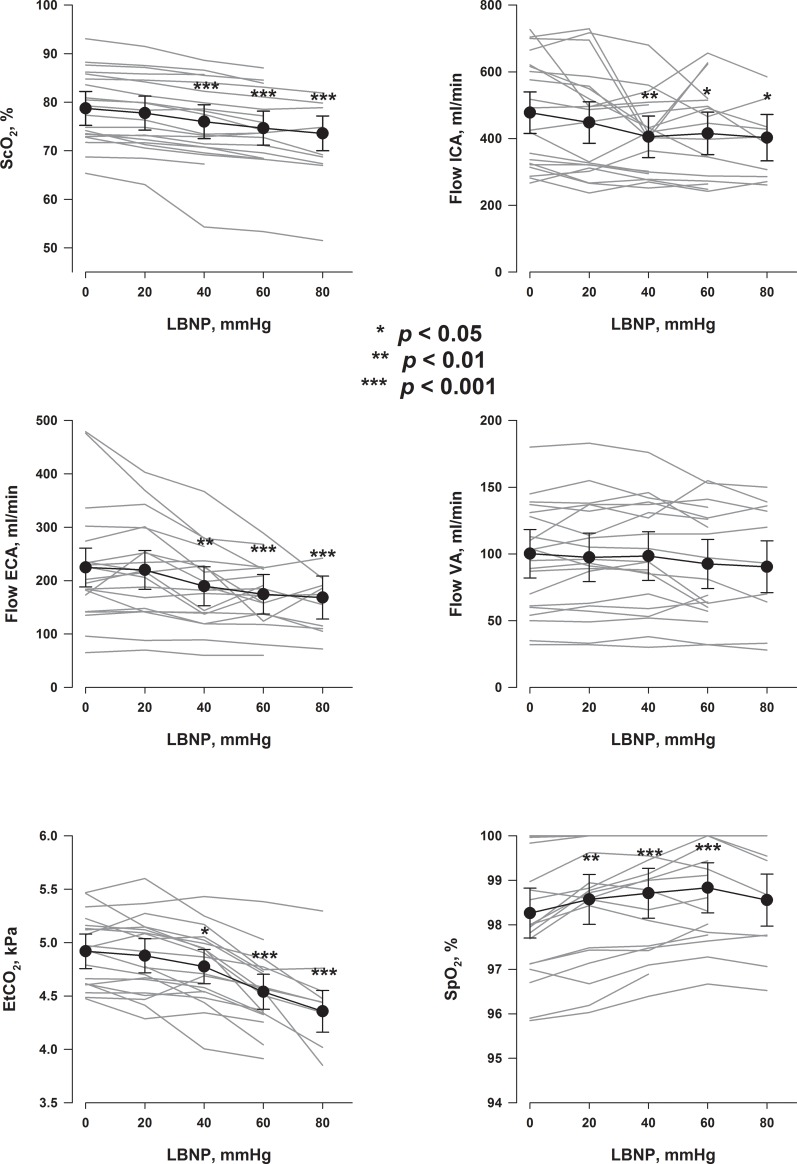
ScO2, precerebral blood flow, EtCO2 and SpO2.Grey lines are values for each subject. Black symbols are estimates with 95% CI for each LBNP-level. P values are for comparisons with LBNP 0 mmHg.